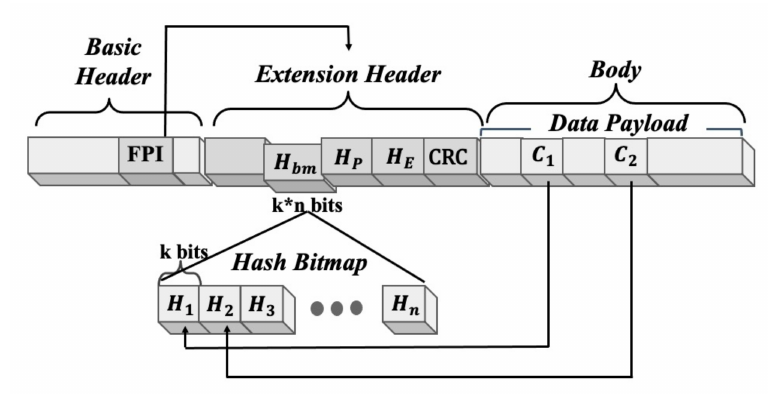
Figure 2. Fast packet inspection (FPI) frame